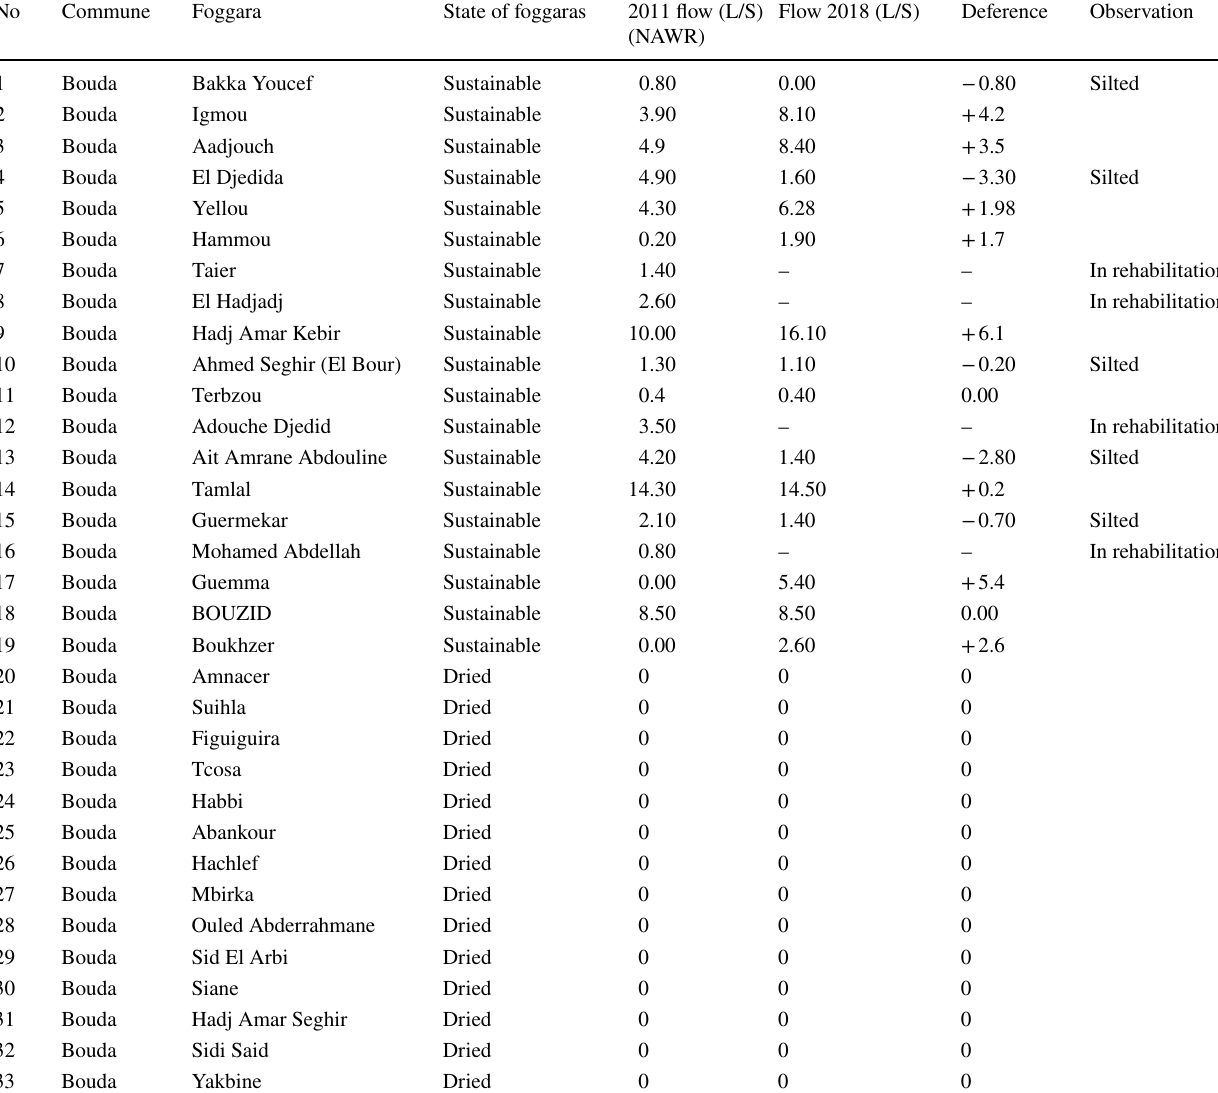
Table 1 Flow of foggaras measured in 2018 in the oasis of Bouda